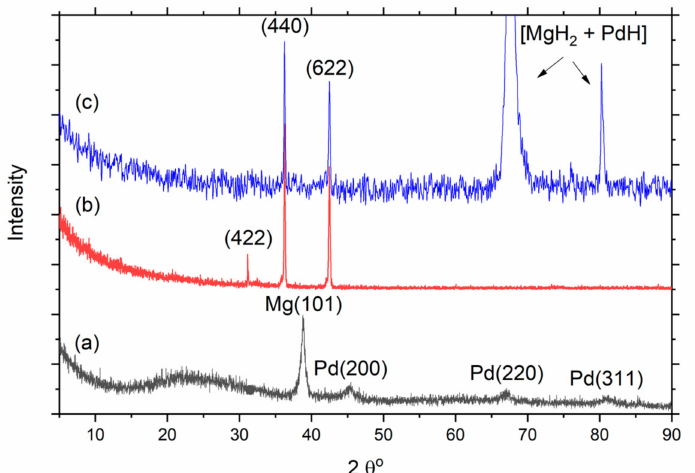
Figure 2. XRD pattern: ( a ) PdMg binary alloy deposited on a glass substrate, and ( b , c ) graphene/ f - MWCNT nanocomposite decorated with PdMg alloy nanoparticles deposited on Pt substrate before and after hydrogenation,